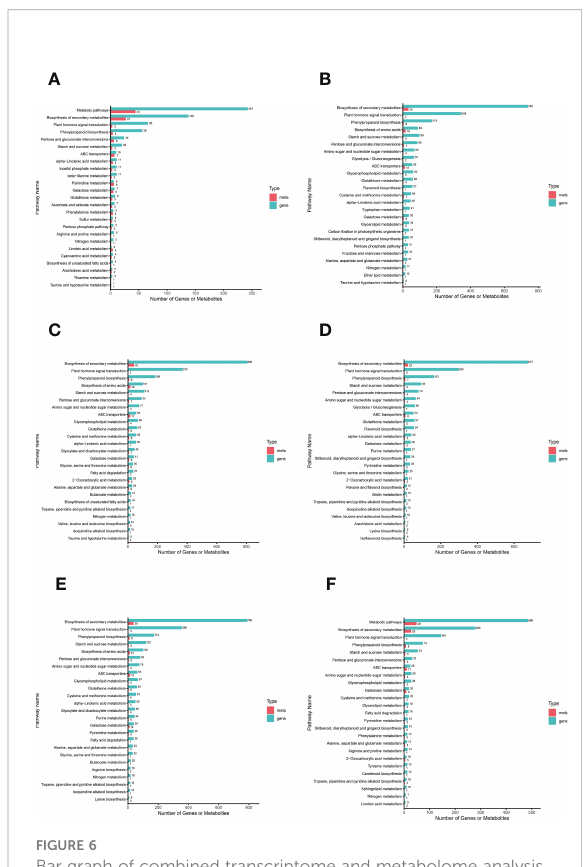
FIGURE 6 Bar graph of combined transcriptome and metabolome analysis. (A) The comparison group of 0 h vs. 1 h. (B) The comparison group of 0 h vs. 12 h. (C) The comparison group of 0 h vs. 24 h. (D) The comparison group of 1 h vs. 12 h. (E) The comparison group of 1 h vs. 24 h. (F) The comparison group of 12 h vs. 24 h. The horizontal coordinates in the bar graph represent the amount of DAMs and DEGs enriched to the pathway, the vertical coordinates represent the KEGG pathway name, and the red and green bars represent the metabolome and transcriptome,